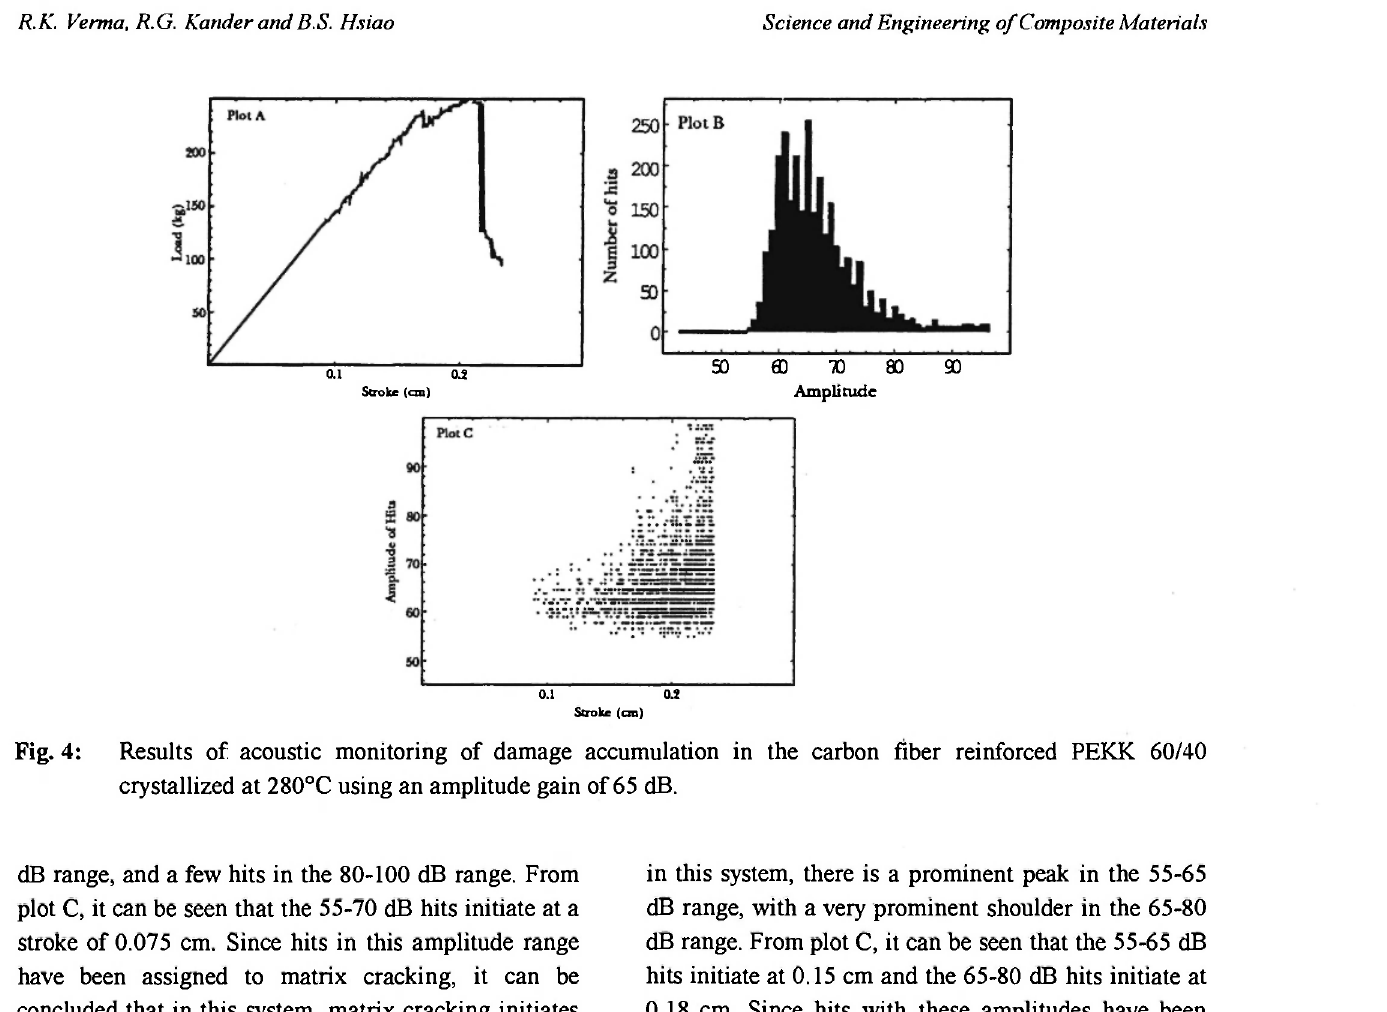
Fig. 4: Results of acoustic monitoring of damage accumulation in the carbon fiber reinforced PEKK 60/40 crystallized at 280°C using an amplitude gain of 65